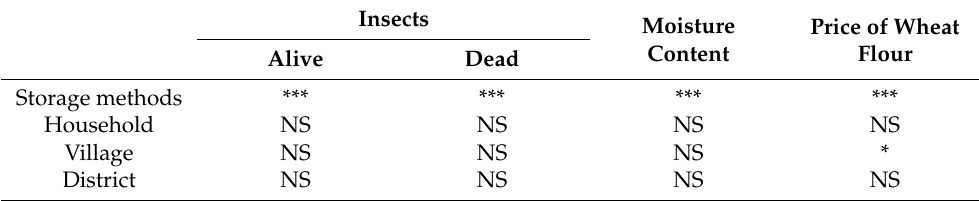
Table 1. The significance of the effect of storage methods, household, village, and district on the number of live and dead insects, moisture content, and price of wheat flour (Afghani, AFA) during wheat flour storage for six months in Herat Afghanistan.